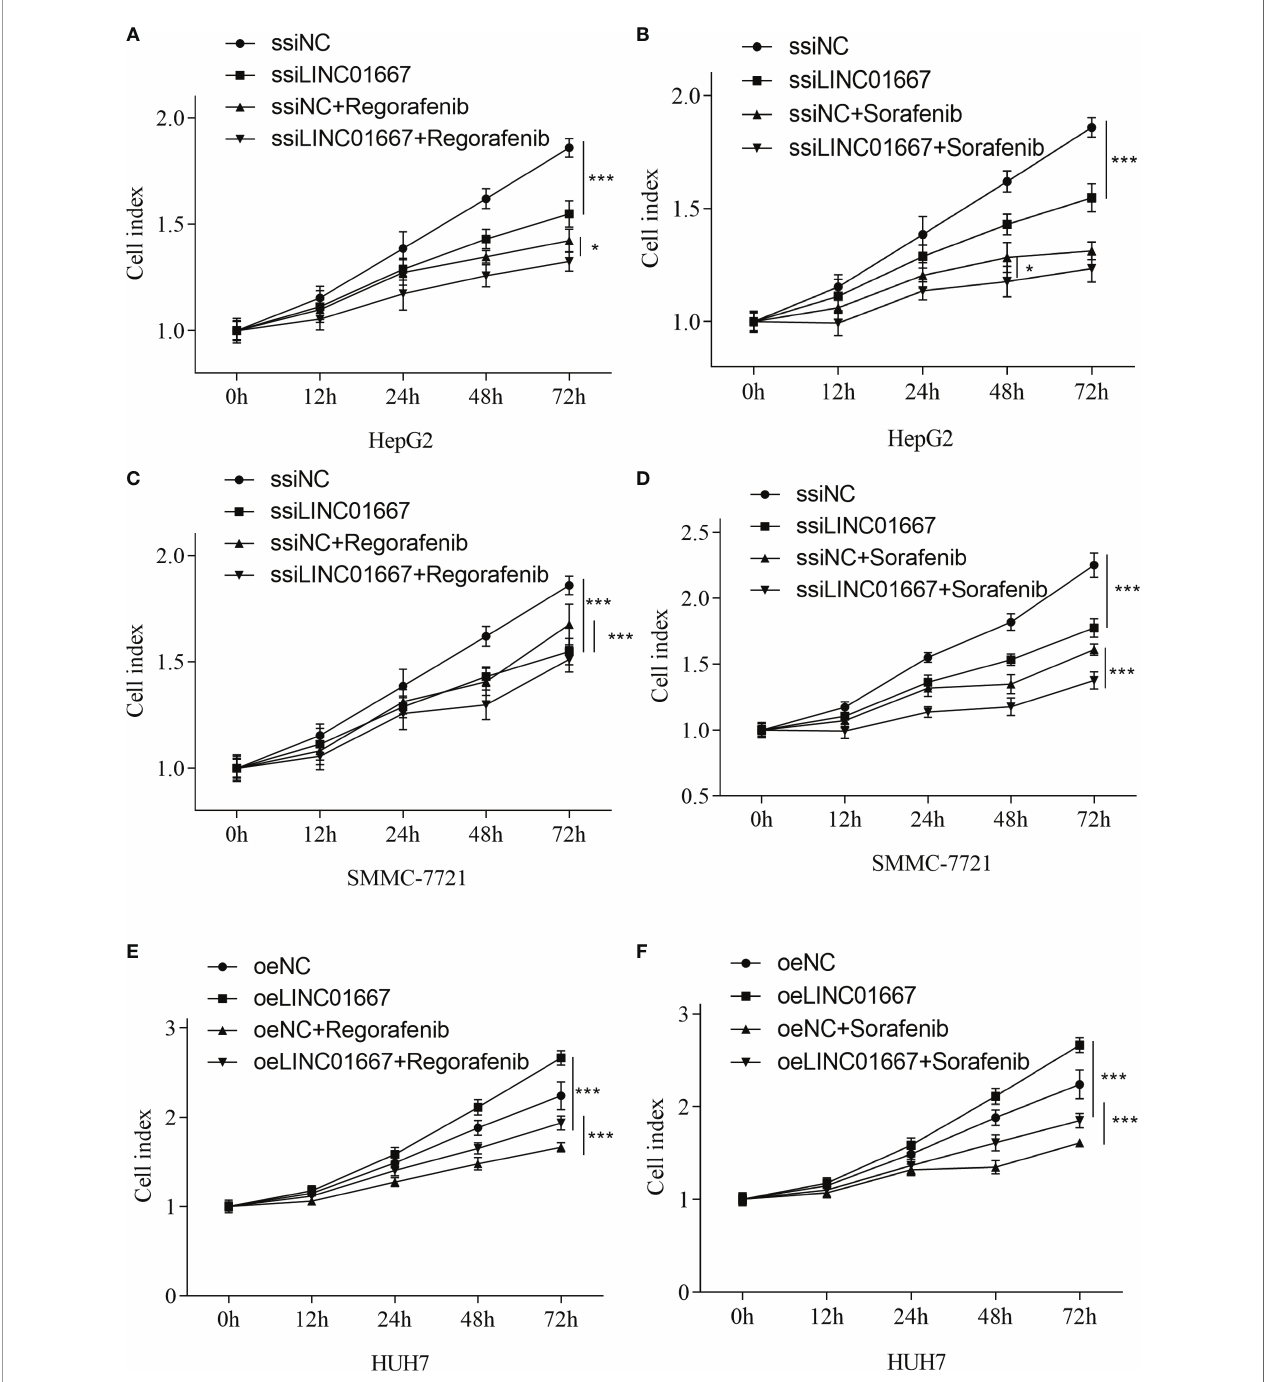
FIGURE 7 | LINC01667 modulates Sorafenib and Regorafenib response in HCC cells. Effect of Regorafenib treatment in cells with (A, C) knockdown of LINC01667 (HepG2 and SMMC-7721) or (E) stable overexpression of LINC01667 (HUH7) compared with the transfected controls. Effect of Sorafenib treatment in cells with (B, D) knockdown of LINC01667 (HepG2 and SMMC-7721) or (F) stable overexpression of LINC01667 (HUH7) compared with the transfected controls. All experiments were performed in 5 copies. * P <0.05, *** P < 0.001. oeNC represents the empty vector group, and oeLINC01667 represents the overexpression LINC01667 group, ssiNC represents the random sequence group, and ssiLINC01667 represents the knockdown LINC01667 group.